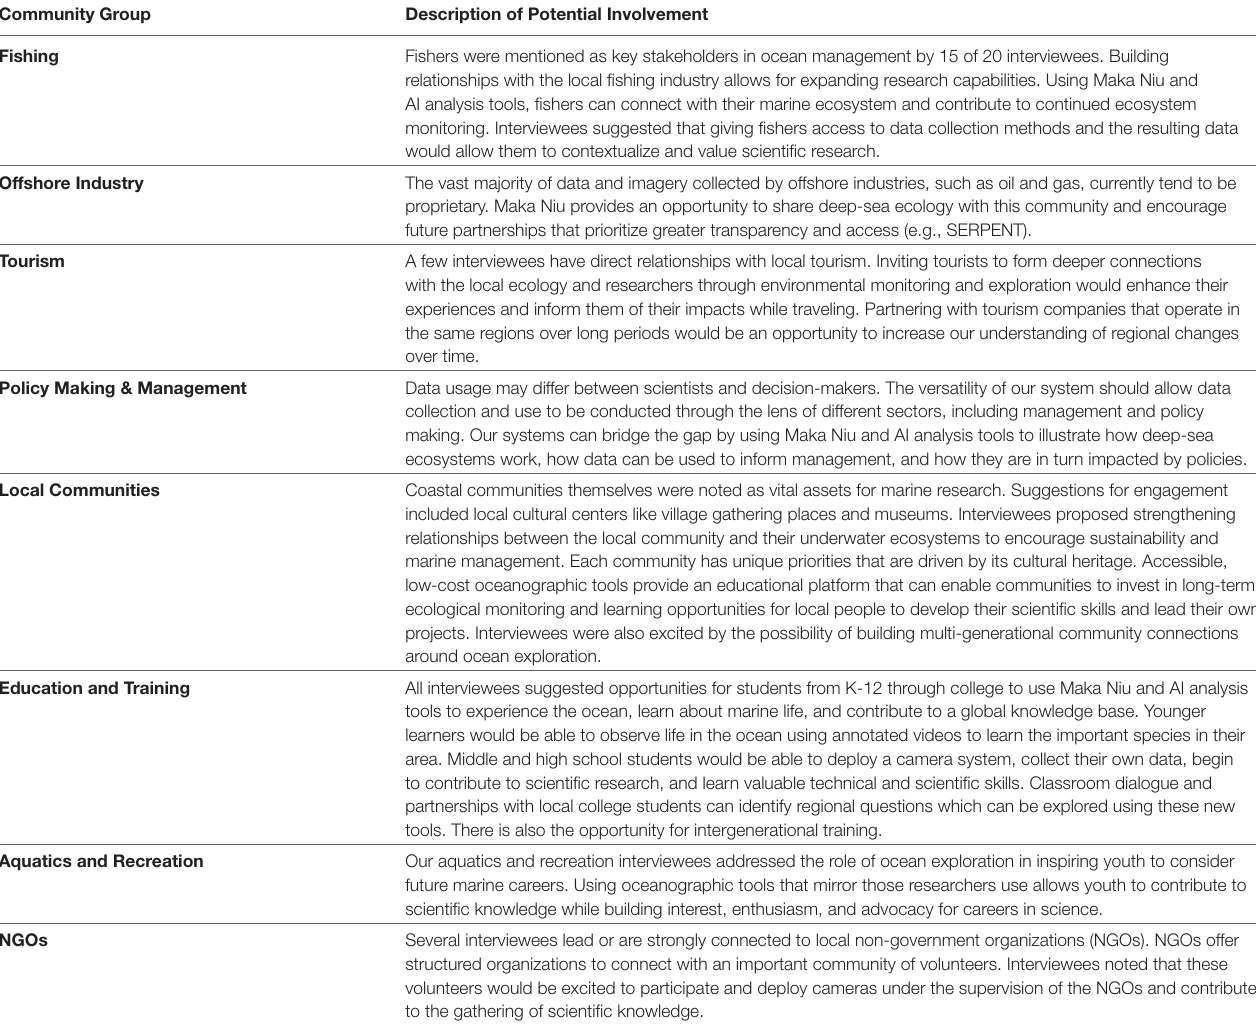
TABLE 2 | Communities and areas of potential involvement in low-cost, deep-sea exploration and research. Community